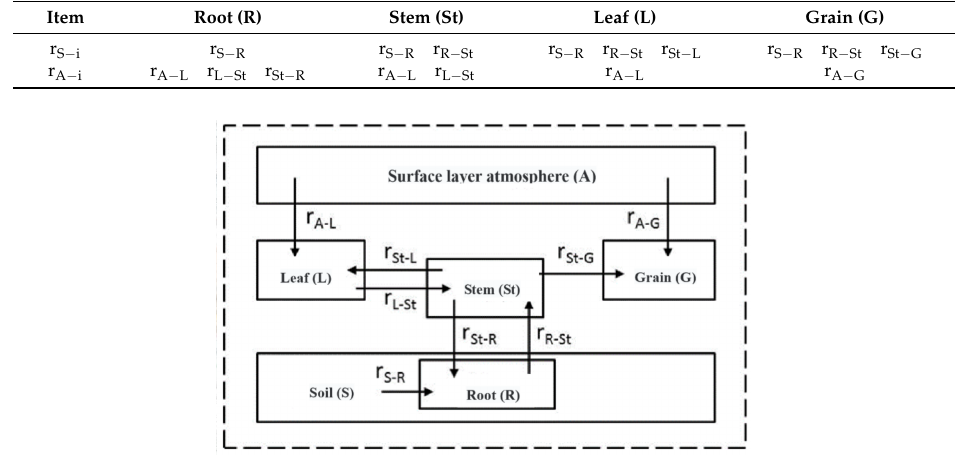
Figure 3. Absorption rate in wheat.